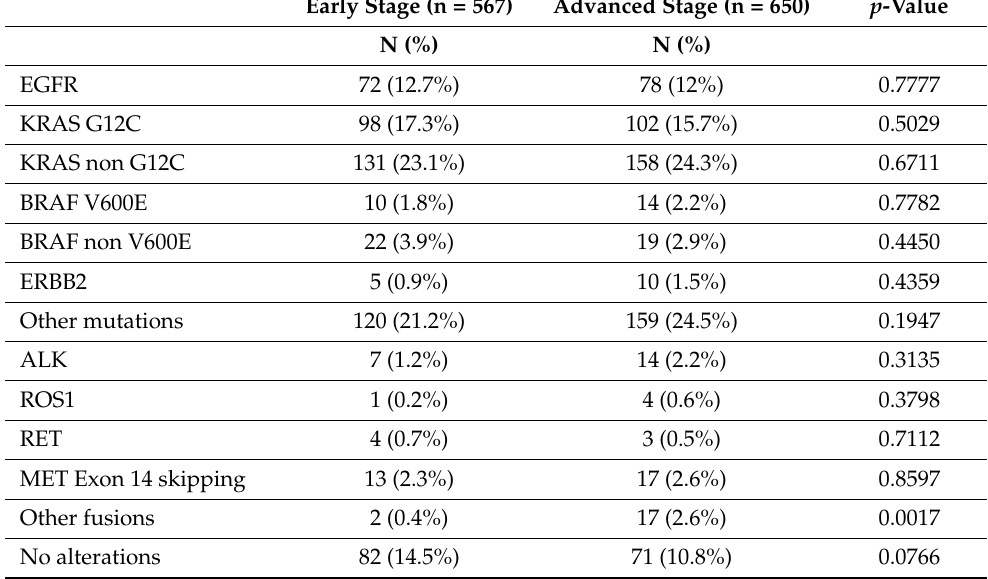
Table 3. Frequencies of genomic alterations in lung adenocarcinoma, detected according to tumor